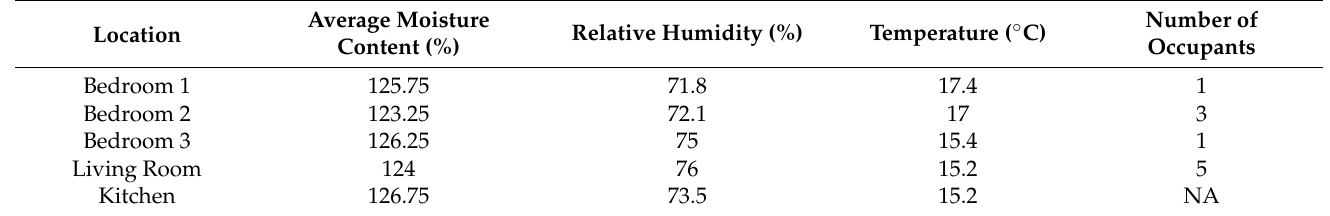
Table 2. Indoor Environmental Quality measurements for the case study house (excludes the bath- room, due to occupants’